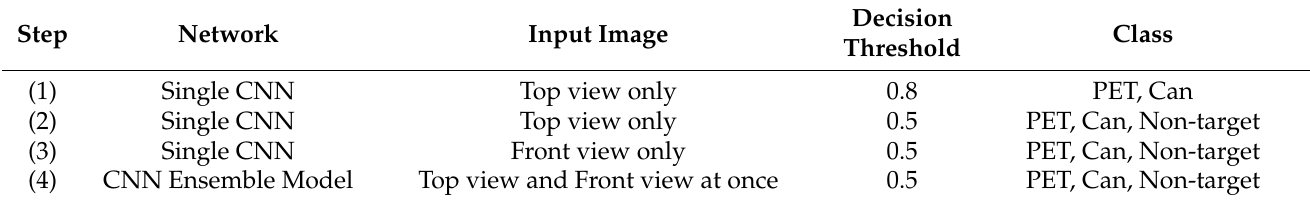
Table 2. Details of our experiments to find optimized classifiers.